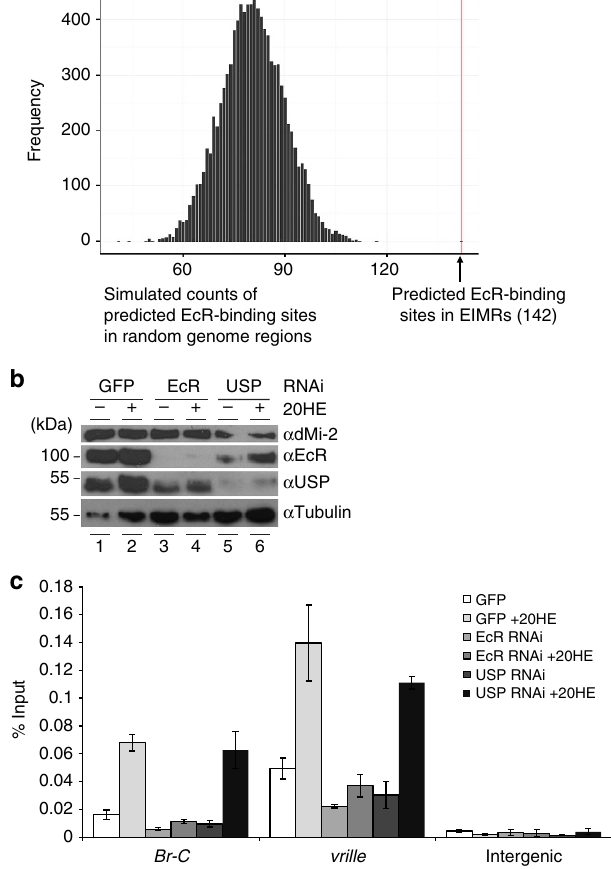
vrille regions displayed increased MNase sensitivity (region A: 80% reduction of qPCR signal, region D: 20% reduction of qPCR signal). We observed similar results in ecdysone-exposed cells.